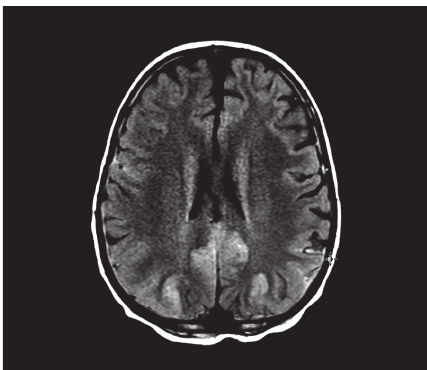
Figure 1: Brain MRI: T2 hyperintensity involving the cortex and possibly subcortical white matter at the occipital and posterior parietal lobes, bilaterally and fairly